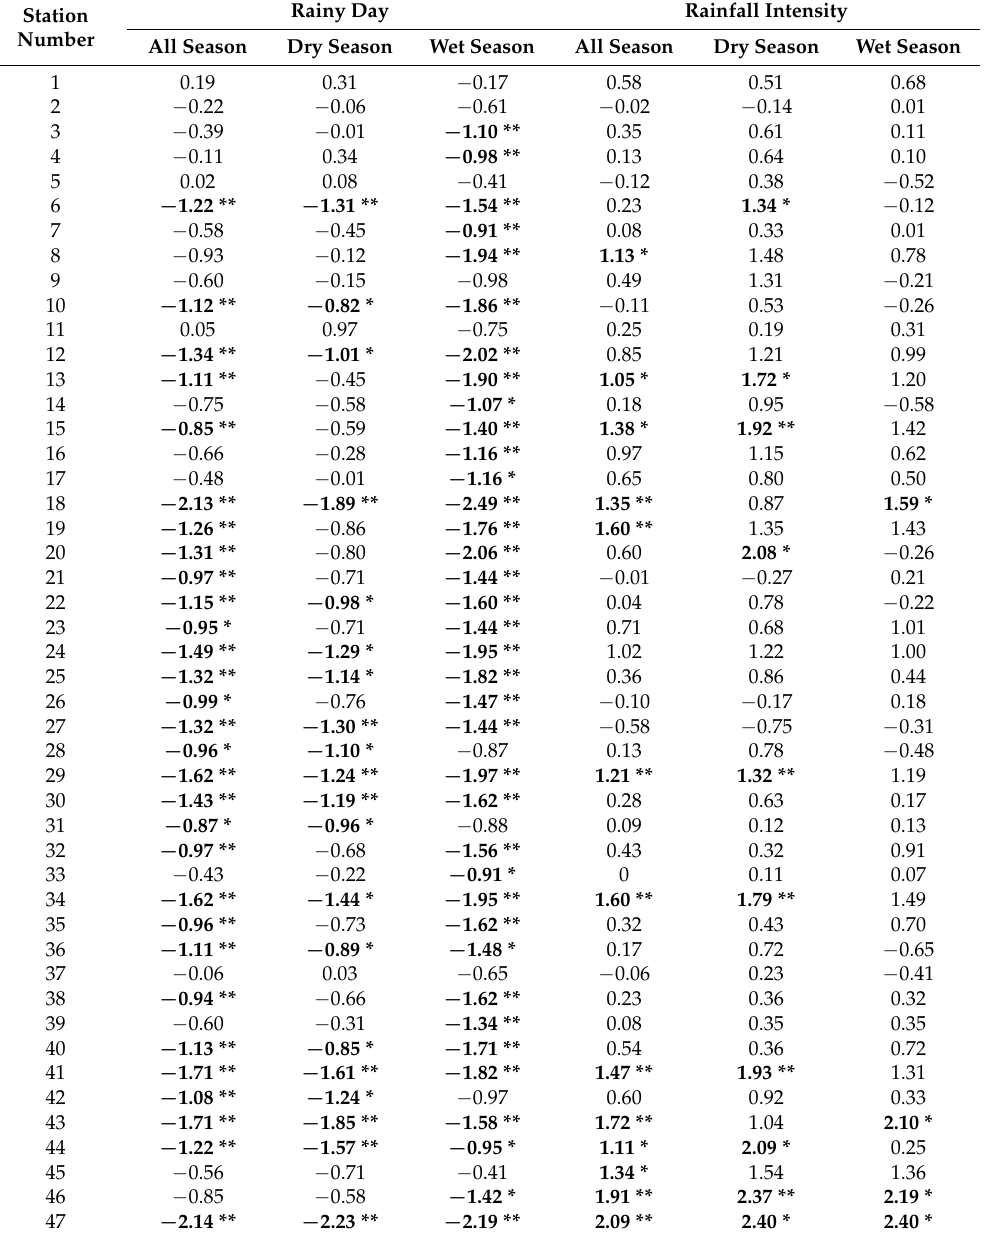
Table 3. Changes in rainy day and average daily rainfall intensity by the PTM index for the dry and wet